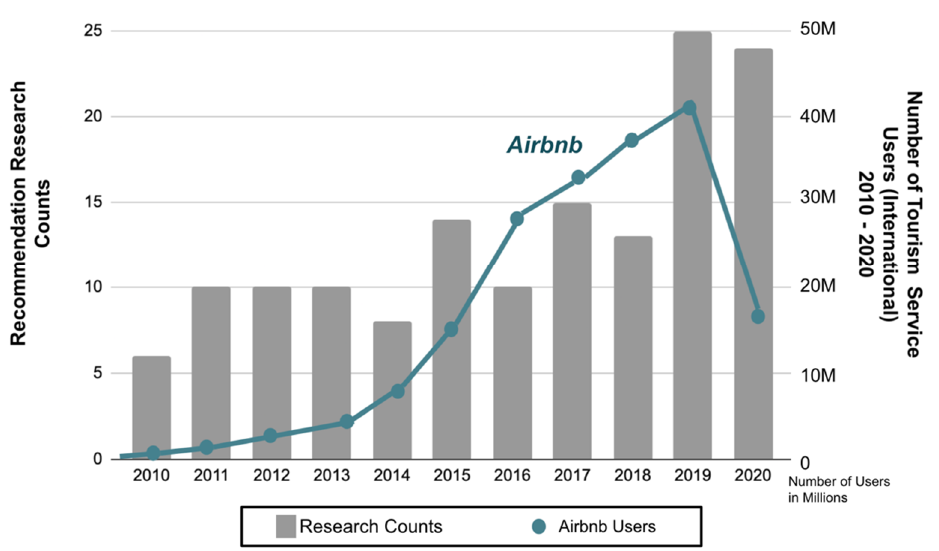
Figure 25. Tourism service field research trends from 2010 to 2021 and the number of users of Airbnb, a representative type of tourism service.